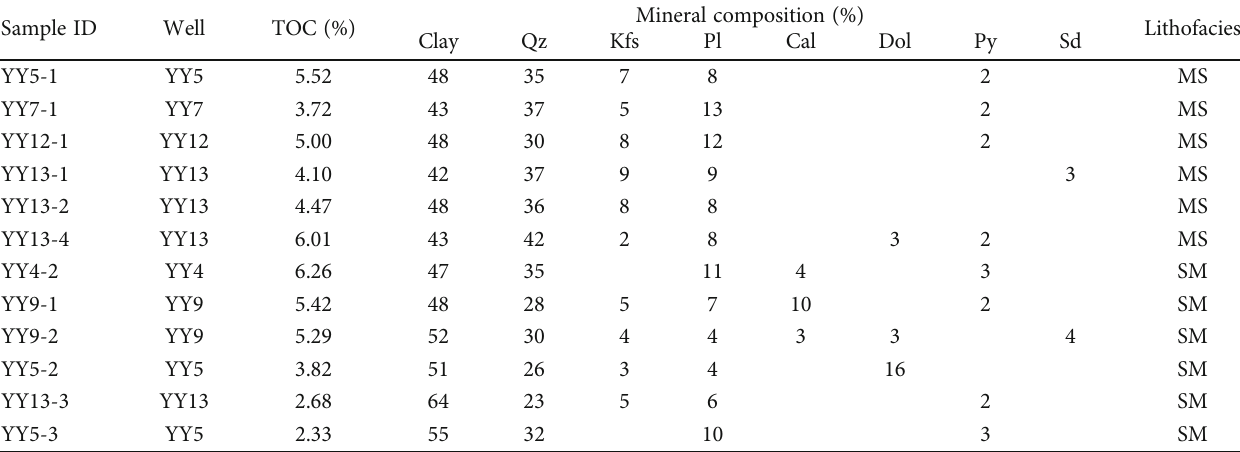
Table 1: Mineral composition, TOC, and lithofacies for Yanchang lacustrine shale samples in the study area. Sample ID